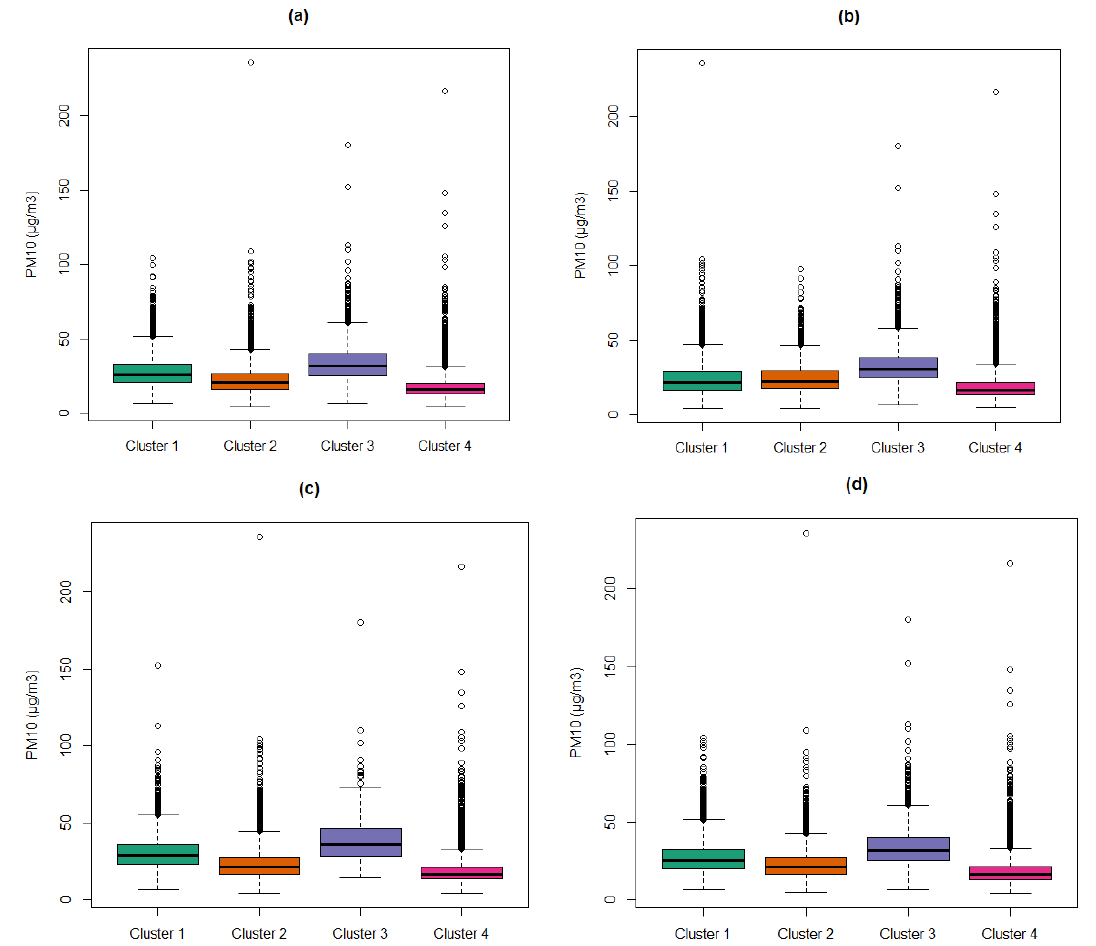
Figure 8. Boxplots for Malaysia PM 10 value ( µ g/m 3 ) according to clusters based on four clustering algorithms for daily average data: ( a ) DTW with k-Means; ( b ) DTW with PAM; ( c ) DTW with hierarchical; ( d ) DTW with FKM. Lower whisker represents minimum observation, lower hinge represents lower quartile, the middle line represents median, upper hinge represents upper quartile, and upper whisker represents maximum observation. Table 1. Minimum, lower quartile, median, upper quartile, and maximum (below upper fence) observations of PM 10 according to clusters based on four clustering algorithms for daily average data extracted from the corresponding